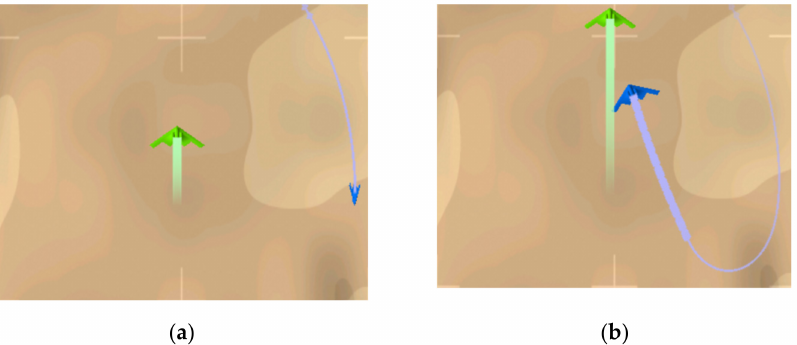
Figure 11. Blue UCAV chasing the green target moving in the horizontal plane: ( a ) early stage of air combat; ( b ) later stage of air combat.